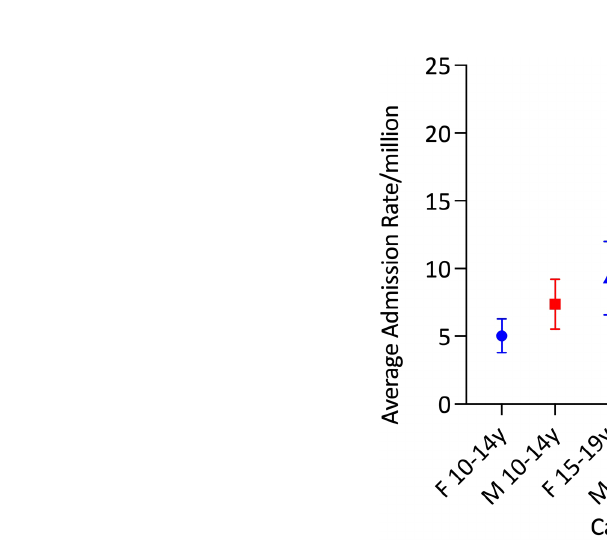
FIGURE 4 Mean adrenal crisis admission rates by age group and